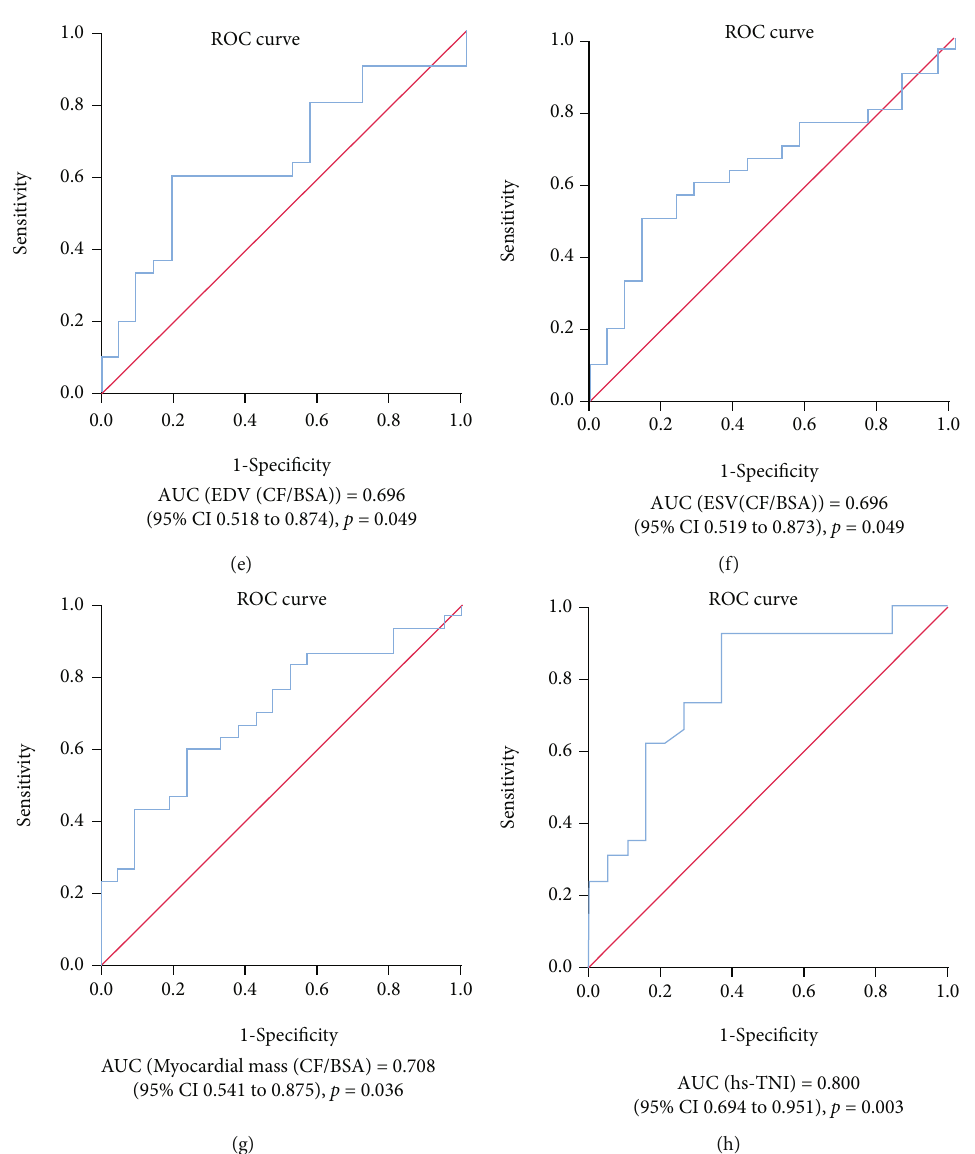
Figure 6: ROC curve for predicting heart failure by (a) basal ECV, (b) ALB, (c) β 2-MG, (d) CK-MB, (e) EDV (CF/BSA), (f) ESV (CF/BSA), (g) myocardial mass (CF/BSA), and (h)